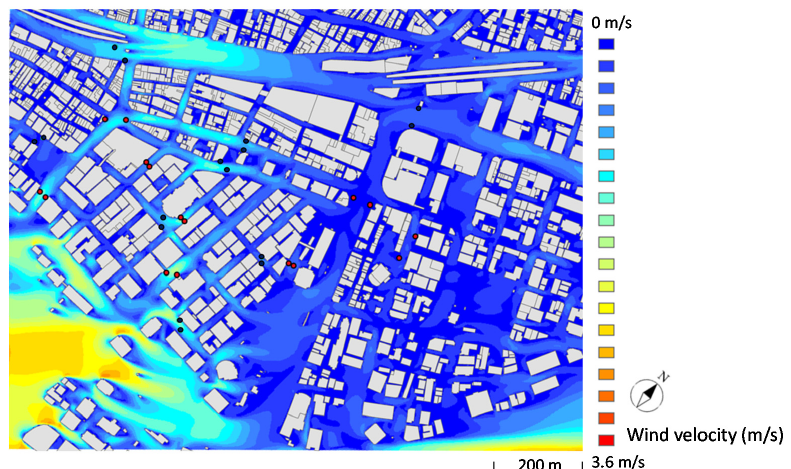
Figure 3. Calculation result of wind velocity distribution at 1.5 m height in analysis area. Red circles (16 pairs) indicate measurement points.